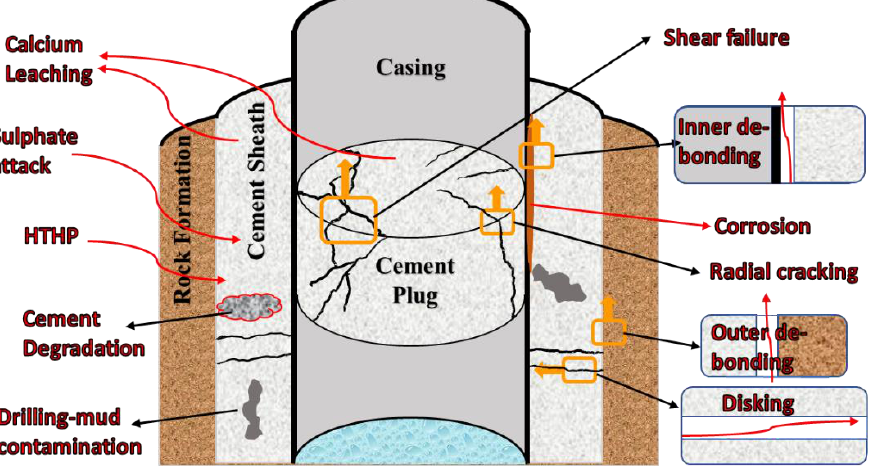
Figure 1. The various possible leakage pathways that could be observed in a wellbore cement plug due to the challenging P&A conditions